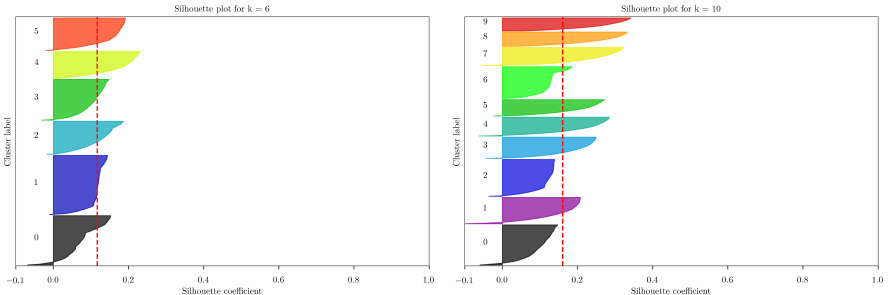
Figure 26. Silhouette coefficient over k for hierarchical agglomerative clustering with raw snapshot data in the POD subspace.